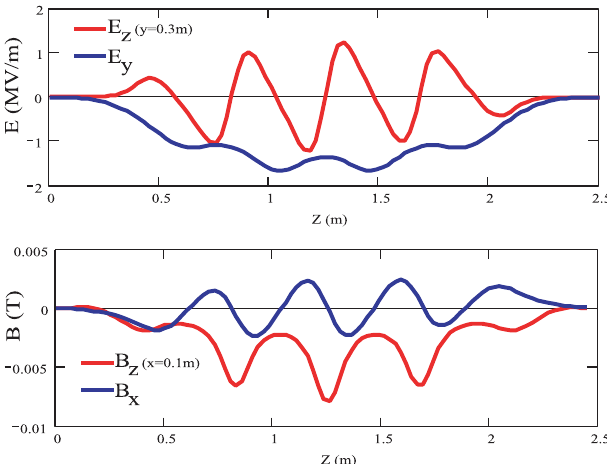
FIG. 3. (Color) Distribution of electromagnetic field amplitudes in the vicinity of the LEP cavity axis for the first dipole mode at 446 MHz. Amplitudes correspond to a stored energy of 1 J. E z and B x amplitudes are linear approximations at the offsets of y ¼ 0 : 3 m and x ¼ 0 : 1 m correspondingly.